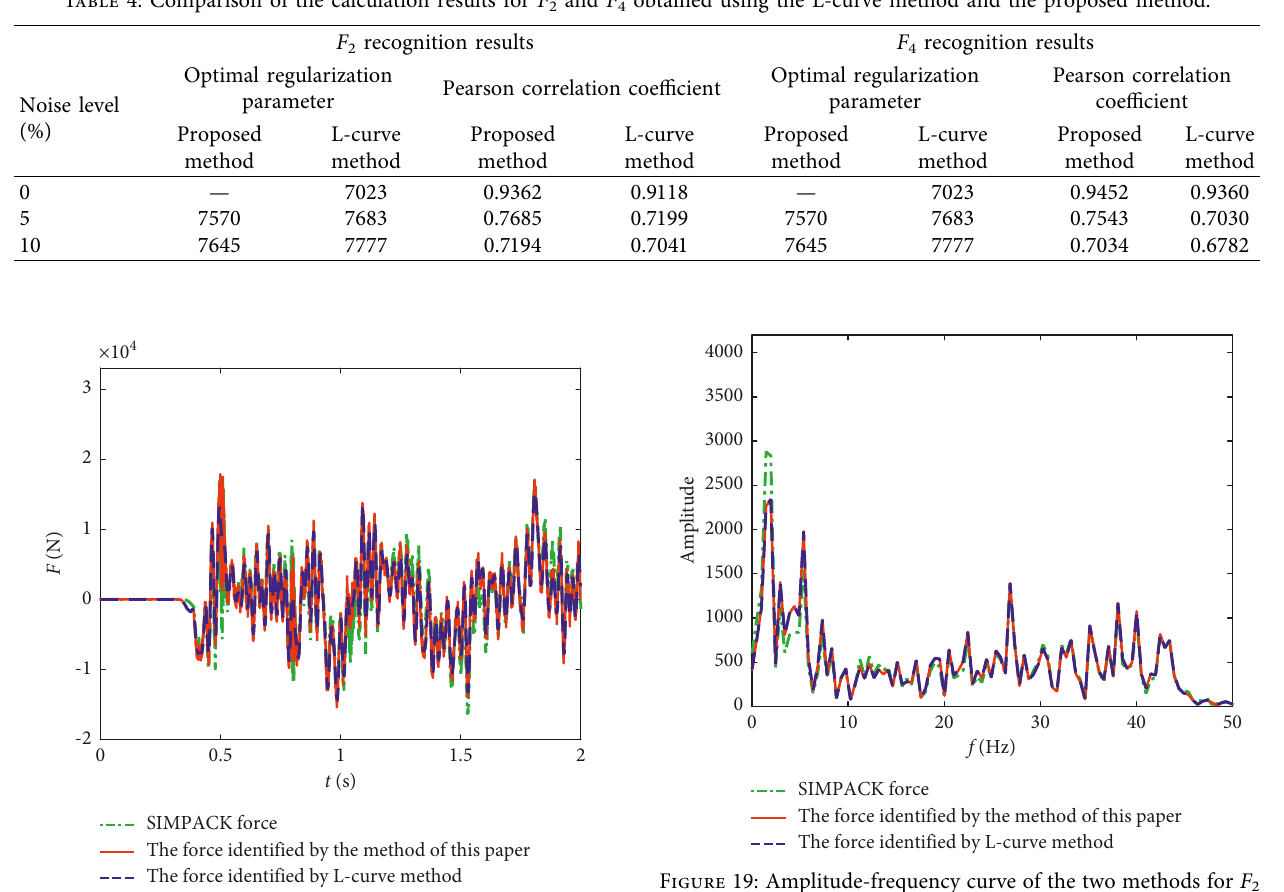
Figure 17: Load time-history diagram of the two methods for F identification when the noise level is 0%.